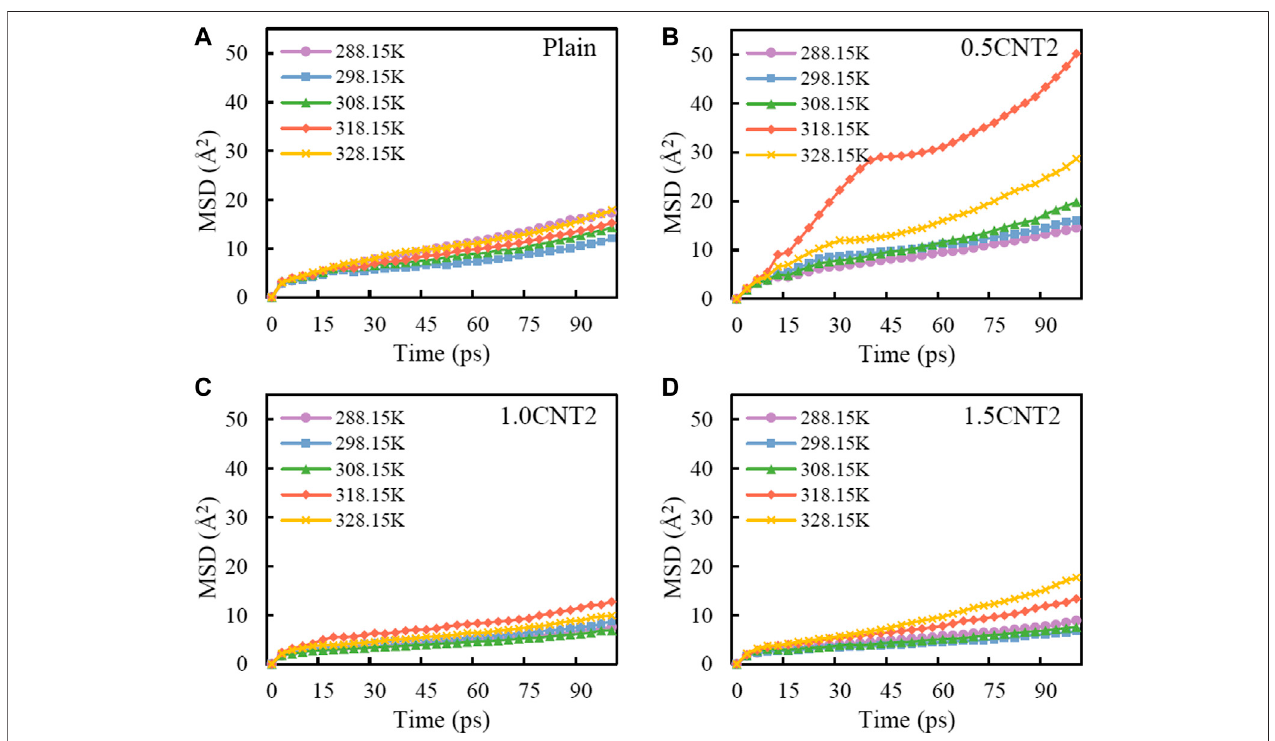
FIGURE 6 | Mean square displacement of the healing process of CNT2 modi fi ed PEN70 asphalt: (A) plain; (B) 0.5% CNT2; (C) 1.0% CNT2; (D) 1.5% CNT2.